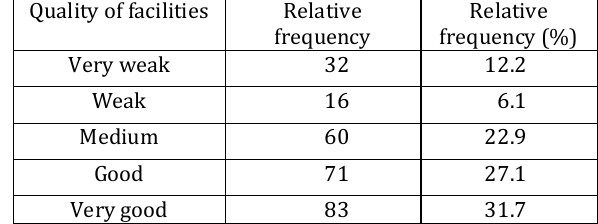
Table 5. Visitor's satisfaction with available welfare facilities